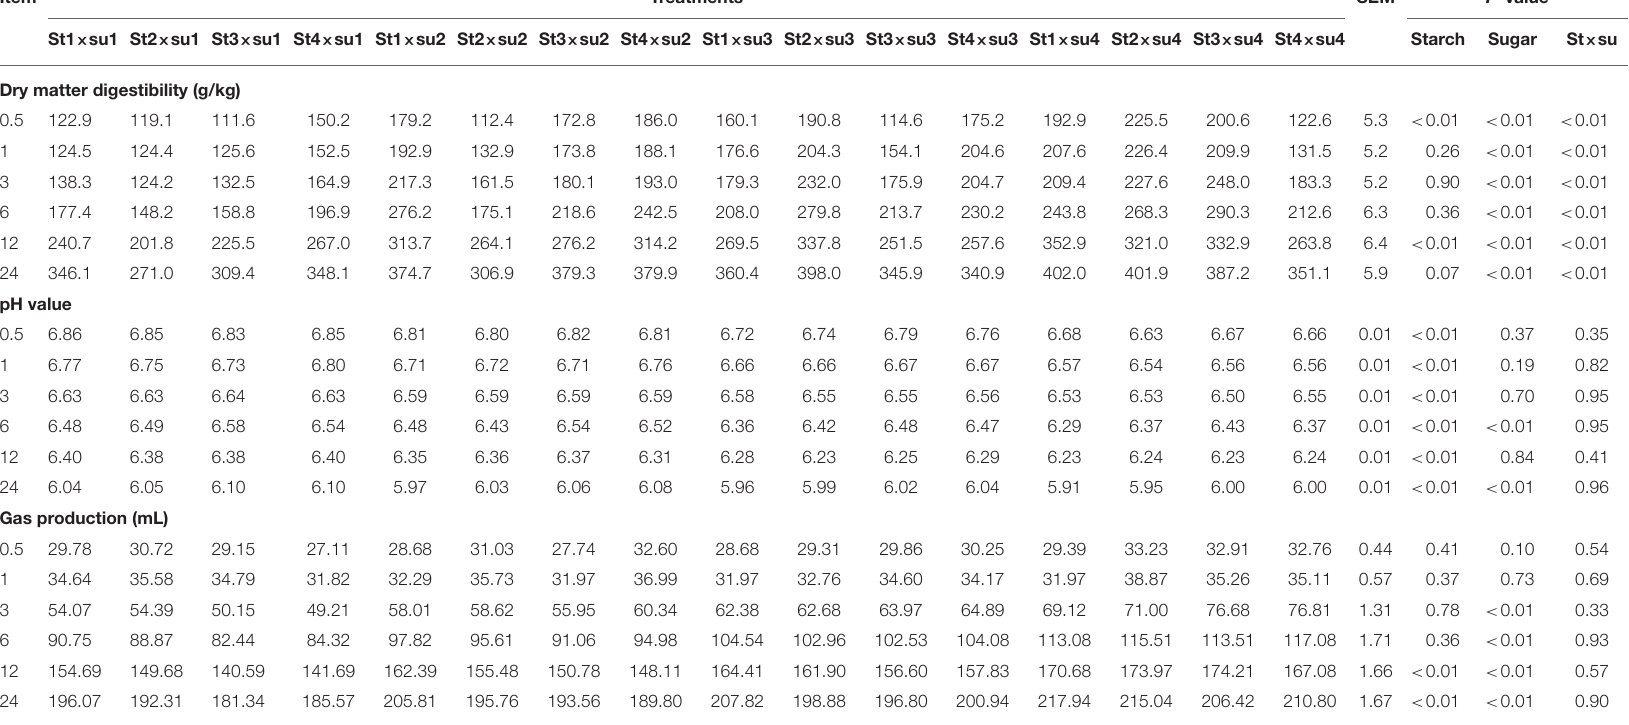
TABLE 1 | Comparison of DM digestibility (g/kg), pH, and gas production (mL) in each group. Item Treatments